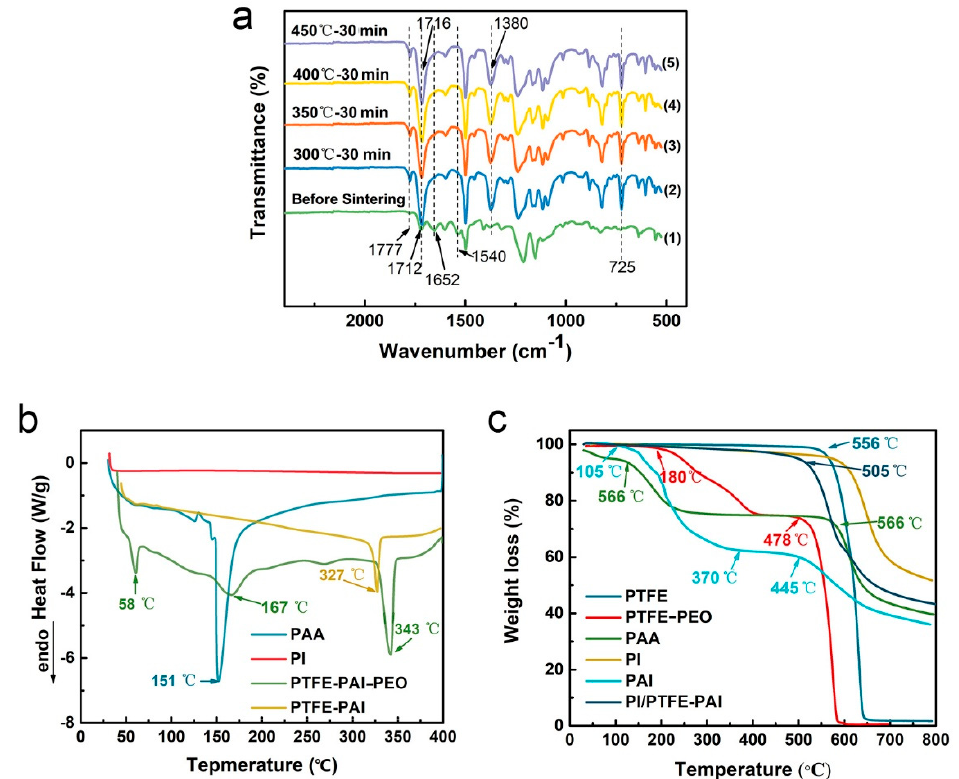
Figure 7 . ( a ) FTIR of PI/PTFE–PAI NAs sintered at different temperatures as PAA/PTFE–PAI was 5:5 and the fiber content was 1.0%; ( b ) the DSC curve of PAA, PI, PTFE–PAI–PEO, and PTFE–PAI nanofiber; ( c ) the TG curves of PTFE NPs, PAI polymer, and PTFE–PEO, PAA, PI, PI/PTFE–PAI